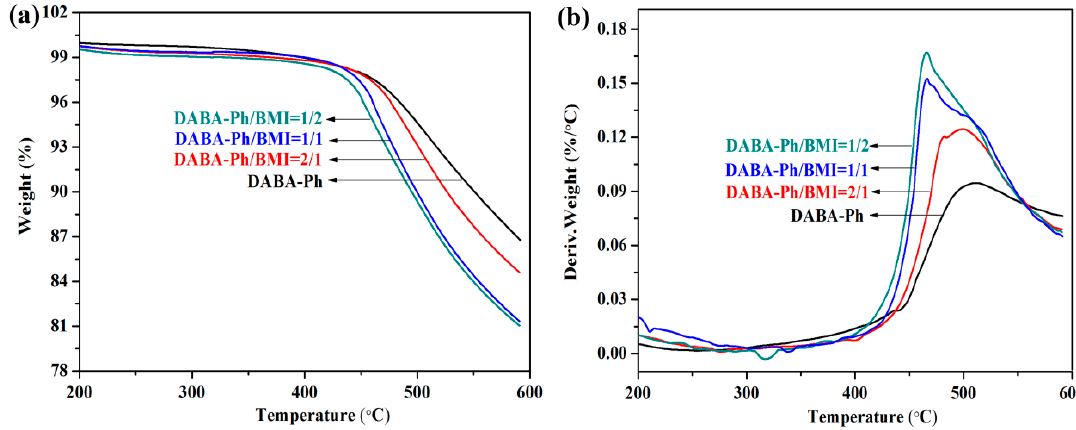
Figure 8. ( a ) TGA curves and ( b ) DTG curves of DABA-Ph/BMI copolymers with various proportions treated at 320 ◦ C. Table 4. Thermal stability of DABA-Ph/BMI copolymers treated at 320 ◦ C.